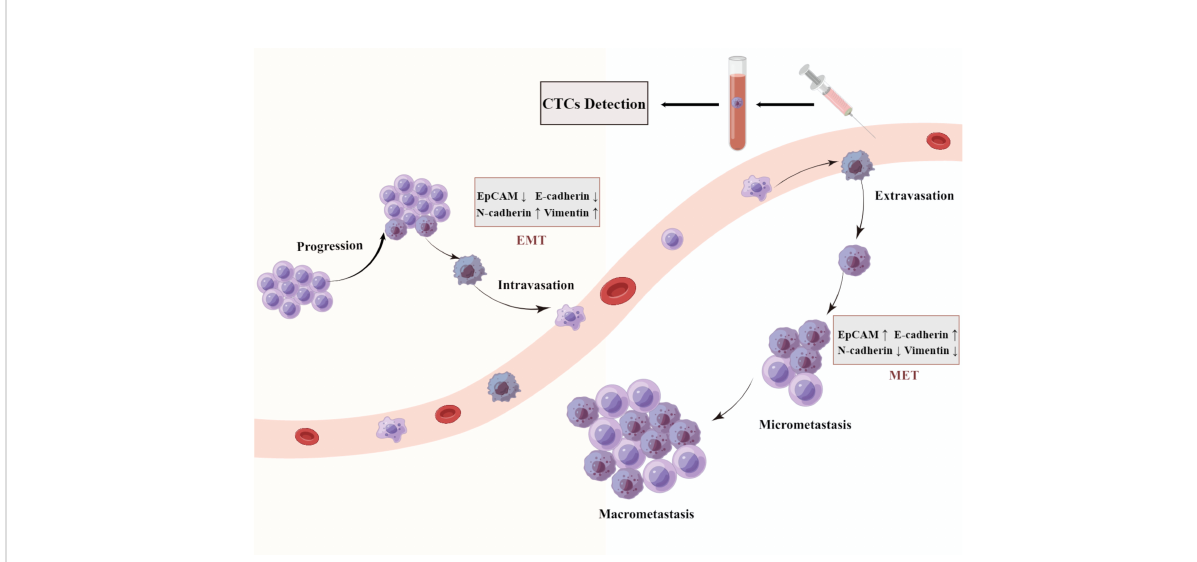
FIGURE 1 A schematic representation of epithelial mesenchymal transition (EMT). Cancer cells detach from the basement membrane and intravasate to the nearby blood vessels as CTC and travel through blood vessels to a secondary site in a process described as metastasis. They get lodged in different organs by a process termed as mesenchymal epithelial transition